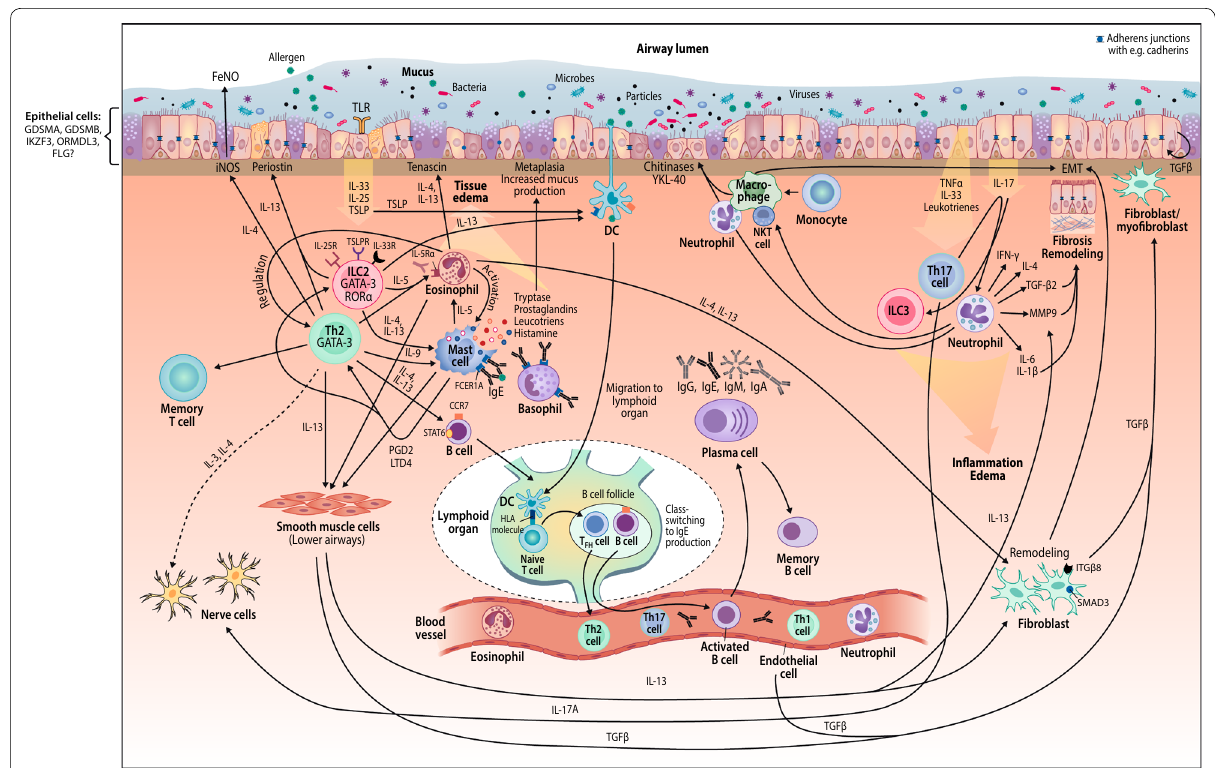
Fig. 5 Postulated mechanisms of GWAS‑related genes in lower airways during asthma. Abbreviations: CCR7 C‑C‑motif chemokine receptor 7, DC Dendritic cell, EMT Epithelial‑mesenchymal transition, FCER1A Fc fragment of IgE receptor 1A, FeNO Fractional exhaled nitric oxide, FLG Filaggrin, GATA-3 GATA binding protein 3, GDSMA Gasdermin A, GDSMB Gasdermin B, HLA Human leukocyte antigen, IgA Immunoglobulin A, IgE Immunoglobulin E, IgG Immunoglobulin G, IgM Immunoglobulin M, IKZF3 Ikaros family zinc finger protein 3, IL Interleukin, ILC2 Group 2 innate lymphoid cells, ILC3 Group 3 innate lymphoid cells, INFγ Interferon gamma, iNOS Inducible nitric oxide synthase, ITGβ8 Integrin Subunit Beta 8, LTD4 Leukotriene D4, MMP9 Matrix metalloproteinase 9, NKT cells Natural killer T cells, ORMDL3 Orosomucoid‑like 3, PGD2 Prostaglandin D2, RORα Retinoid‑Related Orphan Receptor Alpha, SMAD3 SMAD family member 3 ( Mothers against decapentaplegic homolog 3), STAT6 Signal transducer = and activator of transcription 6, TFH cell T follicular helper cell, TGFβ Transforming growth factor beta, Th1 T helper type 1, Th2 T helper type 2, Th17 T helper type 17, TLR Toll‑like receptor, TNFα Tumor necrosis factor alpha, TSLP Thymic stromal lymphopoietin, YKL-40 Chitinase like protein, Remodeling Smooth muscle and/or fibroblast proliferation, fibrosis, EMT